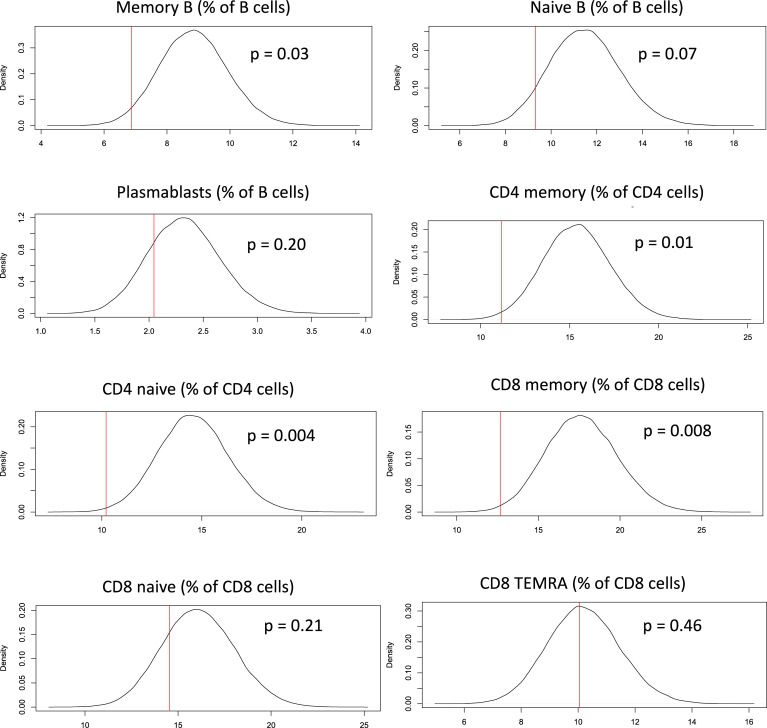
Comparison of sibling-pair differences versus unrelated-pair differences.Each panel indicates an immune cell subset expressed as frequency of parent lineage gate. Vertical red line represents the mean difference in sibling pairs. Density histograms represent distribution of differences in large number of unrelated-pairs. The farther the red vertical line towards the left, the greater is the significance level and indicates that sibling-pair differences are smaller than unrelated-pair differences. The p-values as calculated from the distribution by resampling methods are indicated in the plots.